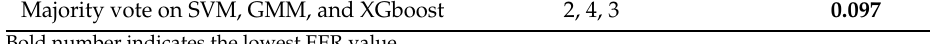
Table 9. EER for SCAD with different classifiers on the ASVspoof 2017 version 2.0 Benchmark Da- taset .